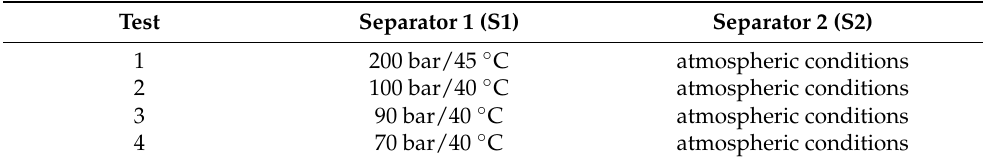
Table 1. Fractionation conditions of the two cyclone